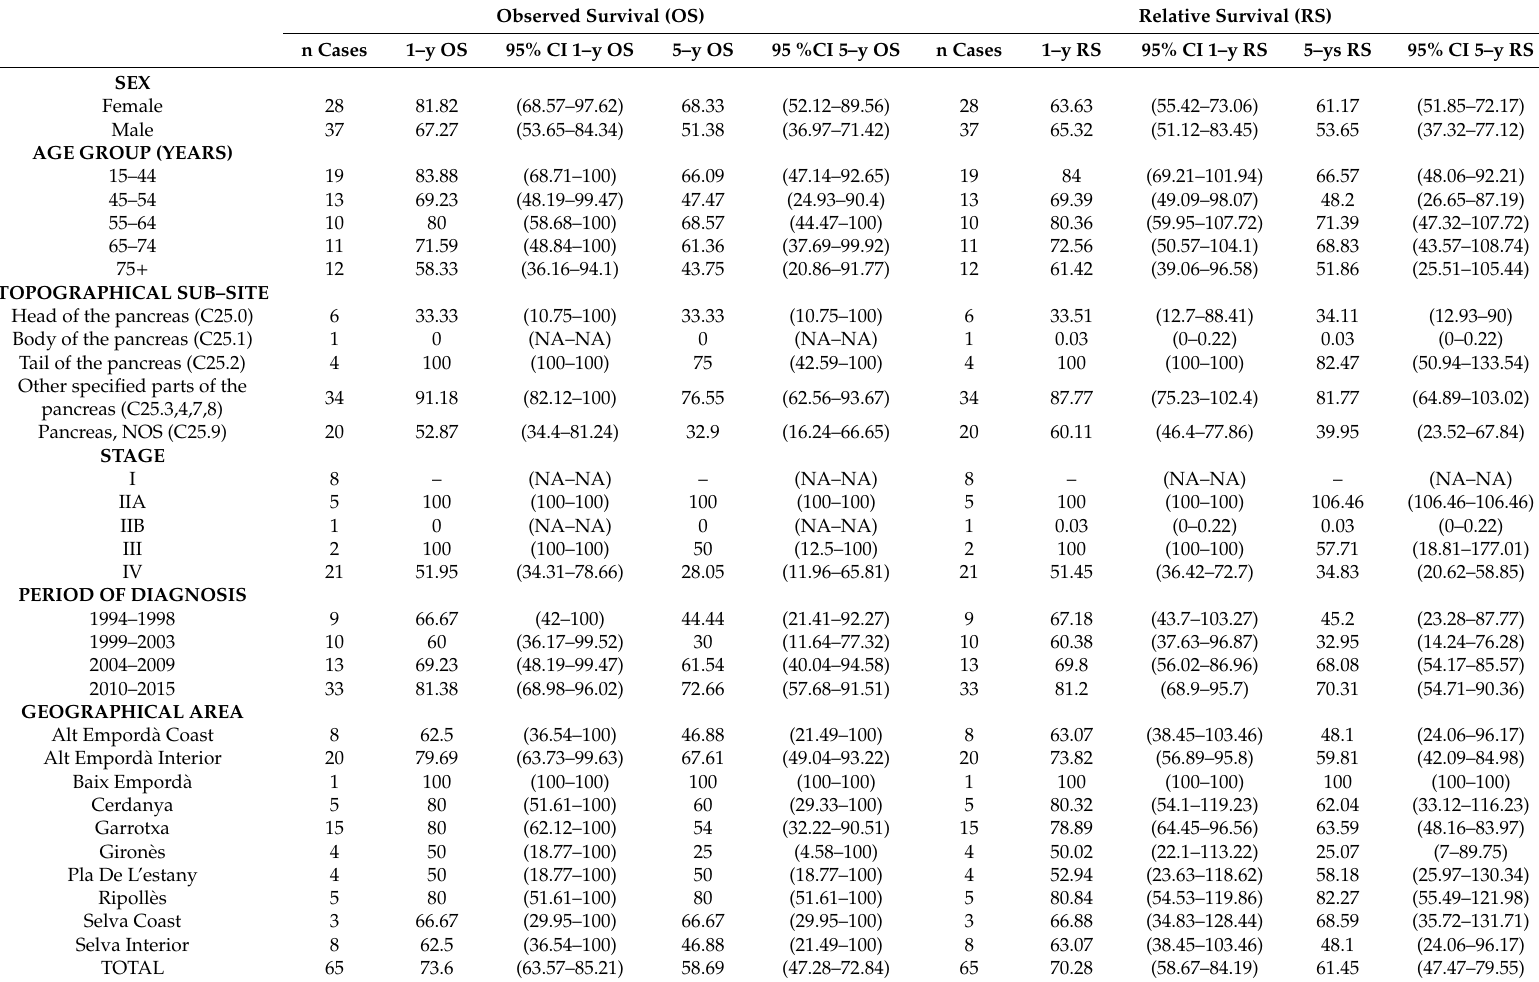
Table 5. One and 5-year observed and relative survival for PNETs by sex, age, stage, period of diagnosis, sub-site and county. Girona province,